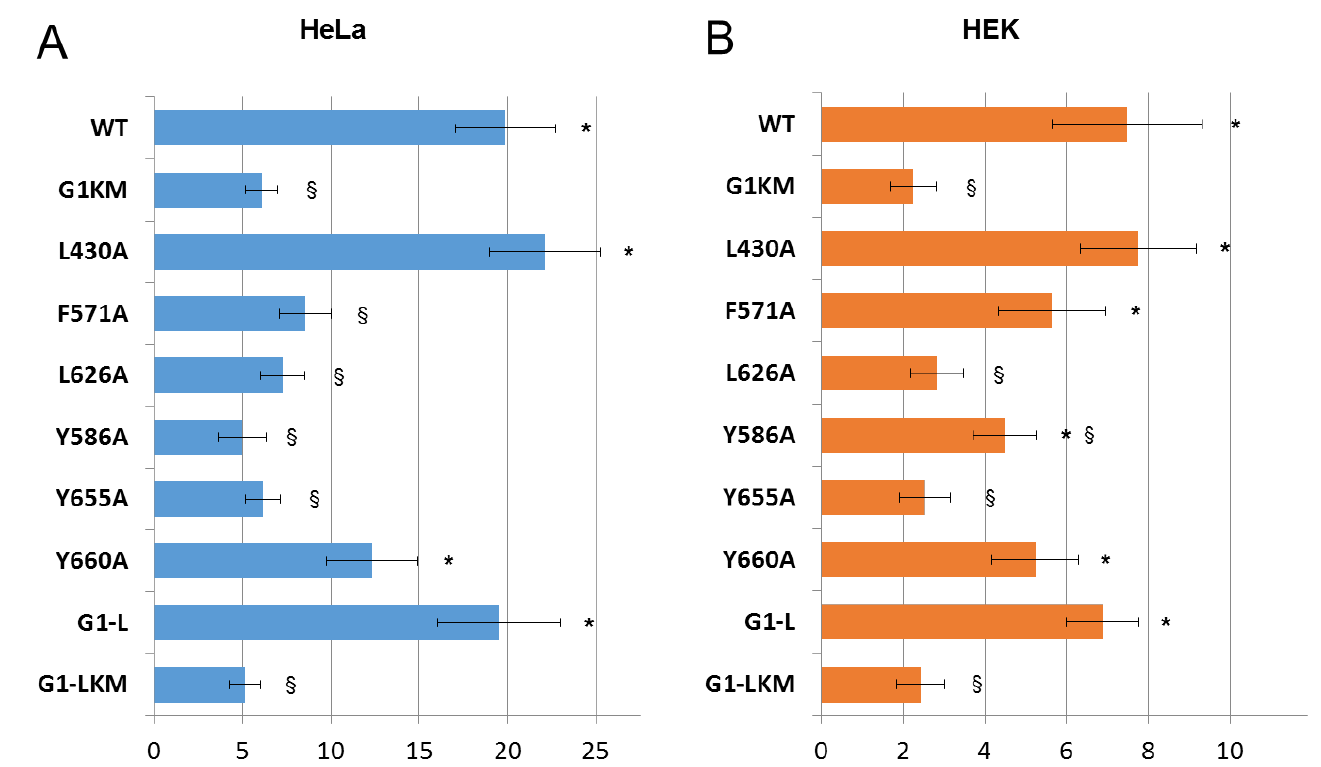
Figure 4. Apoptosis induced by various ABCG1 mutants. Variants of ABCG1-S were expressed in HeLa ( A ) and HEK293 ( B ) cells, and the fraction of the apoptotic cells was determined by Annexin V binding. For comparison, the apoptotic effects of the long form (G1-L) and its inactive mutant variant (G1-LKM) are also shown. Section marks (§) and asterisks (*) indicate significant differences as compared to wt ABCG1 (WT) and G1KM, respectively ( p <